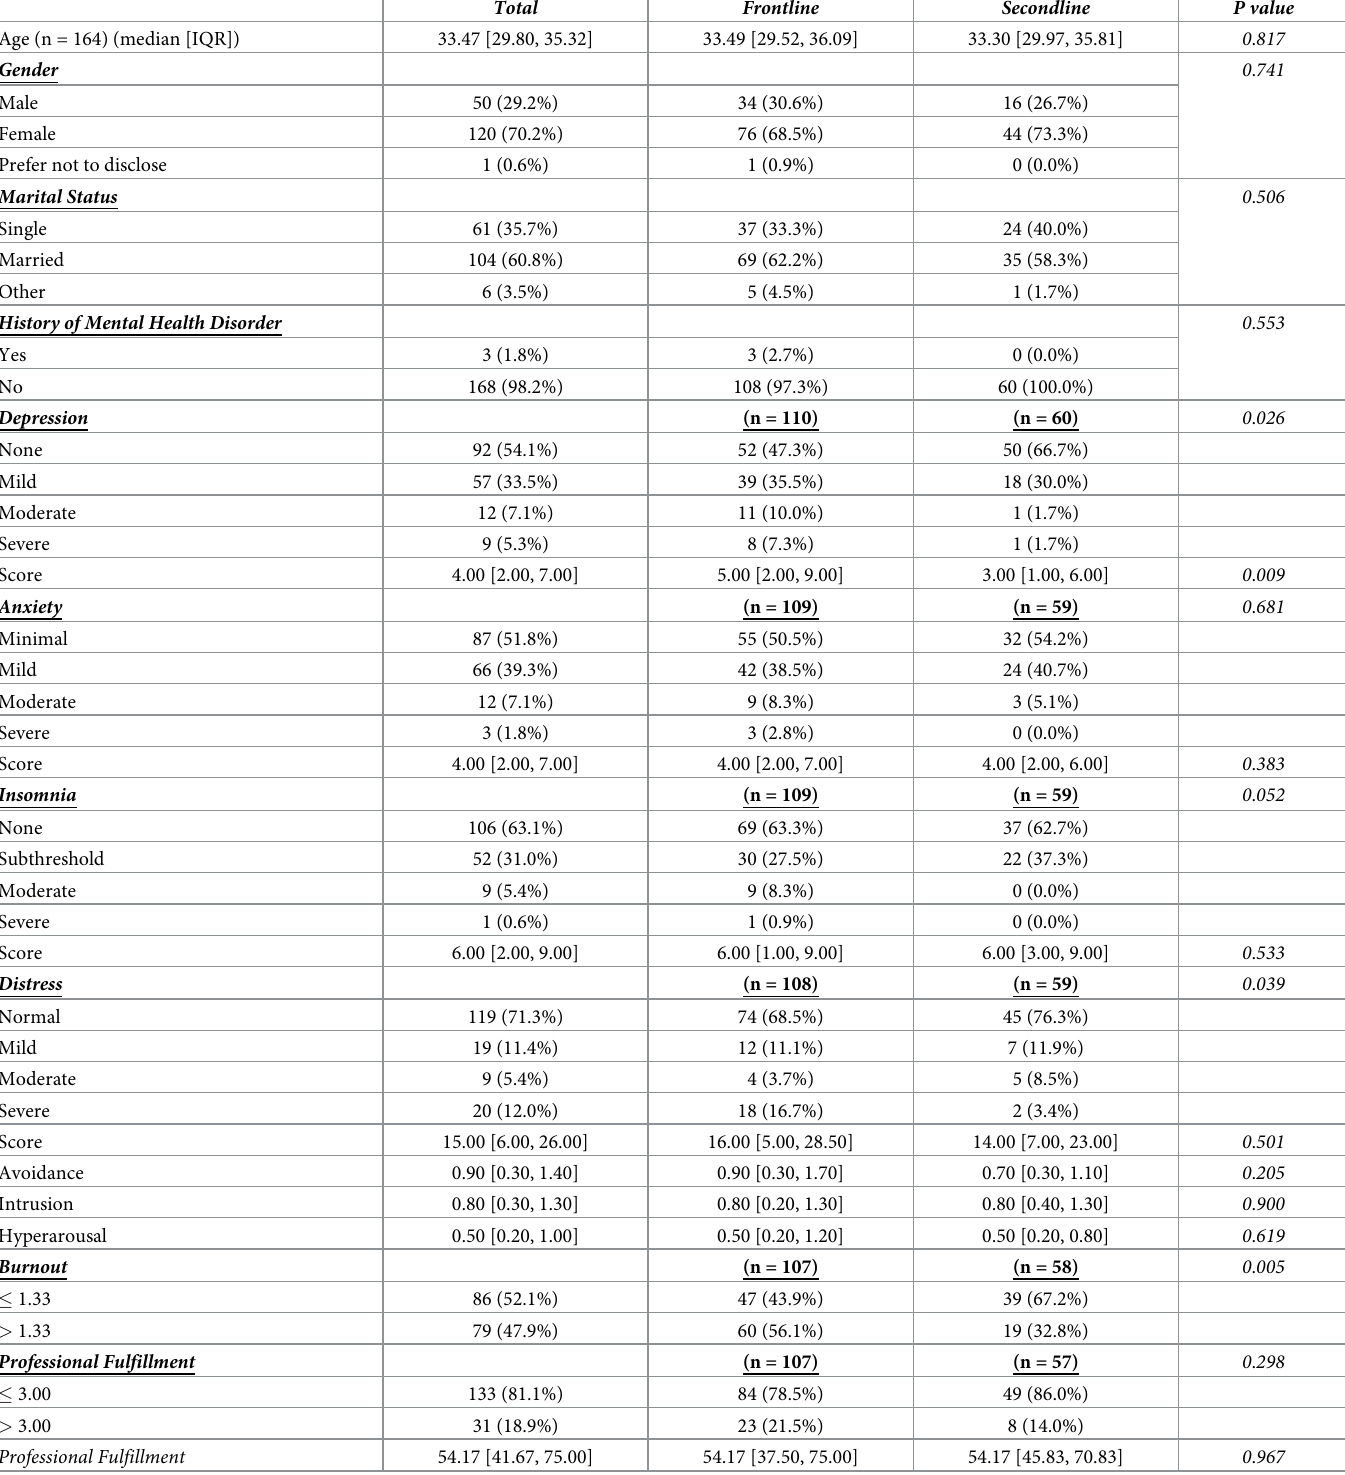
Table 1. Comparison of demographic and mental health disorders among the frontline and second line